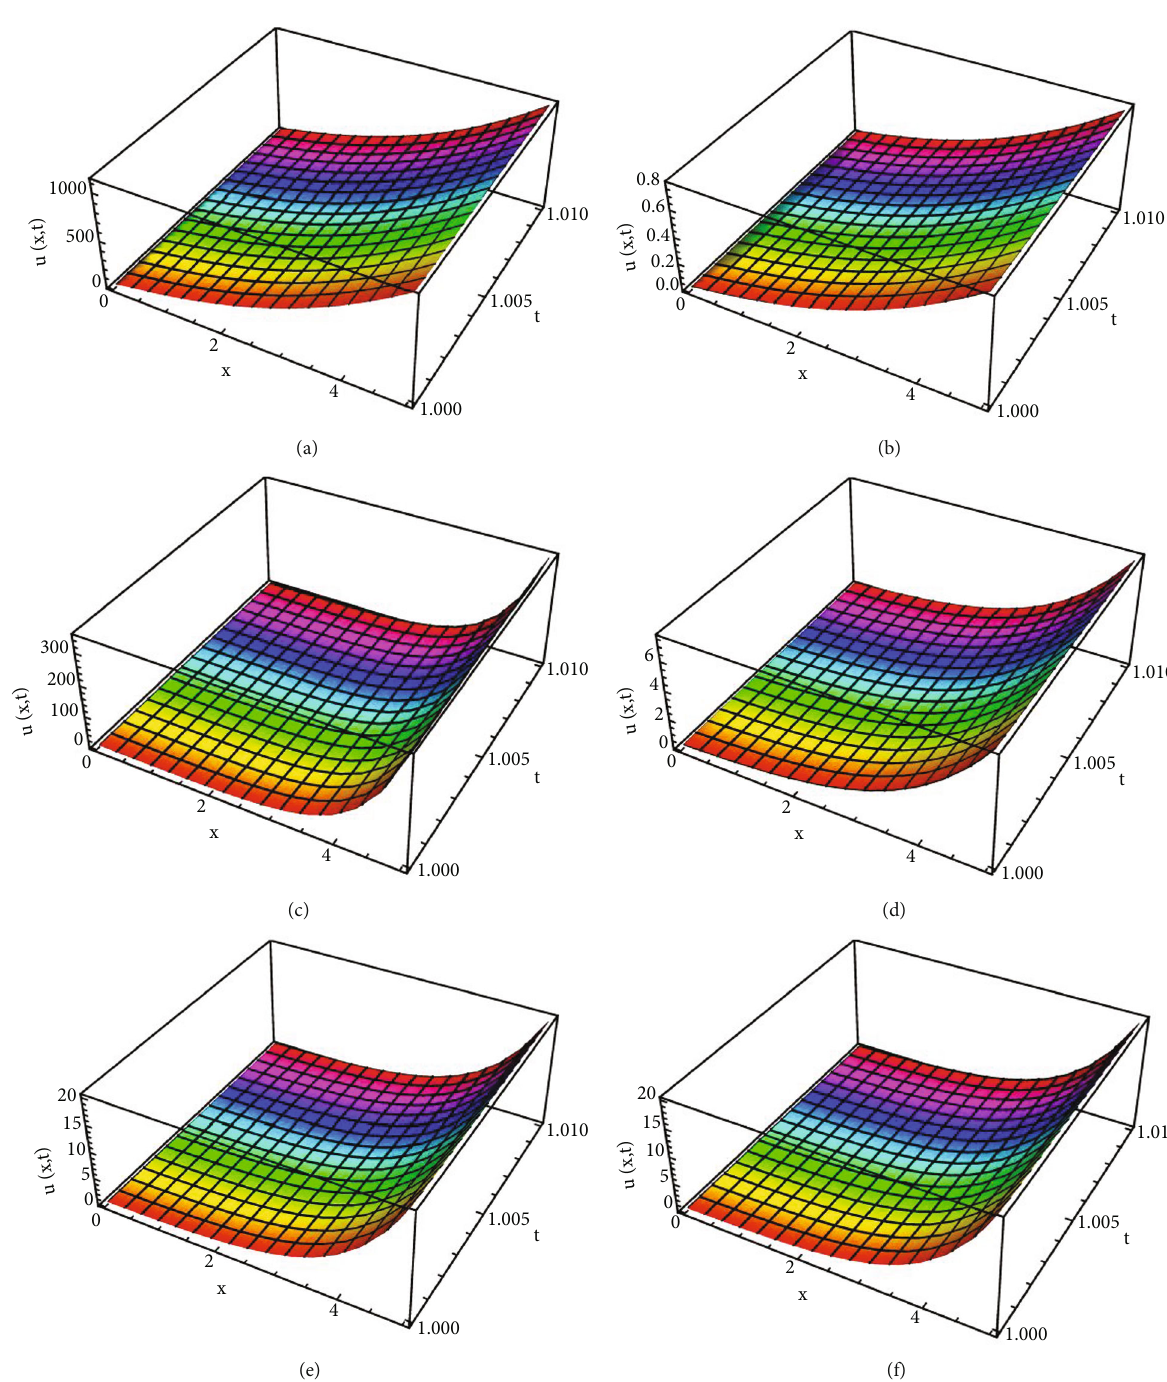
Figure 2: 3D solution plots of Example 2 obtained by the present method (a, c, e) in comparison with the exact solutions (b, d, f) at α = β = 0 : 4 , 0.8, and